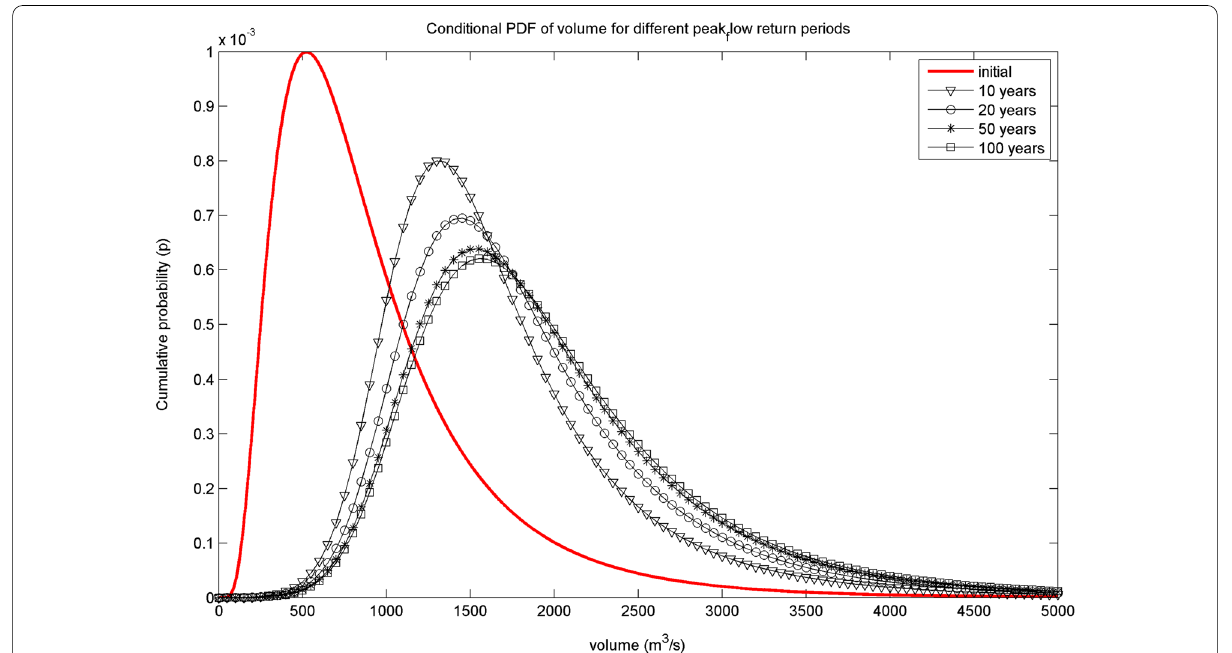
Fig. 13 Probability density functions of volume under different peak flow return